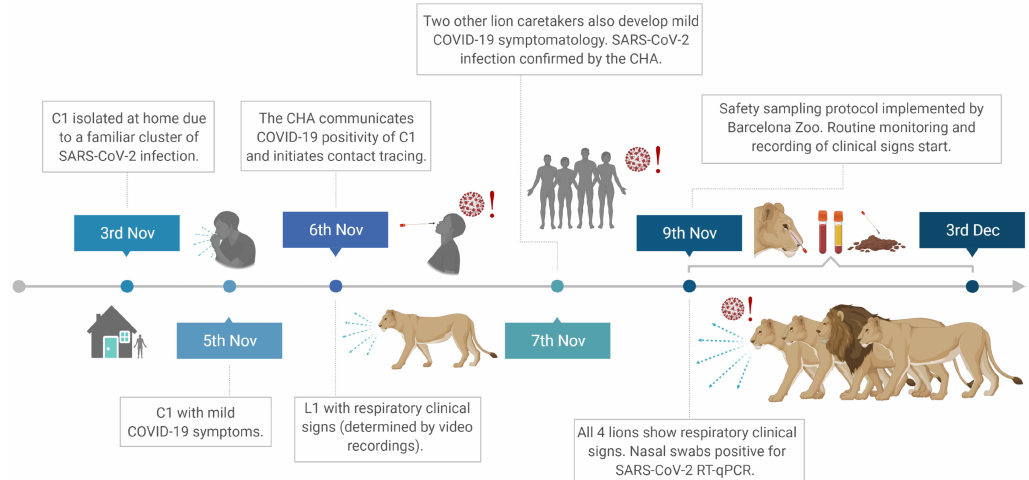
Figure 1. Chronological events summarizing the outbreak and human-to-lion transmission that occurred at the Barcelona Zoo. Abbreviations: C1, lion caretaker 1; COVID-19; coronavirus infectious disease 2019; CHA, Catalan Health Agency. L1, Lion1; SARS-CoV-2, severe acute respiratory syndrome coronavirus 2. This figure was created using BioRender.com.